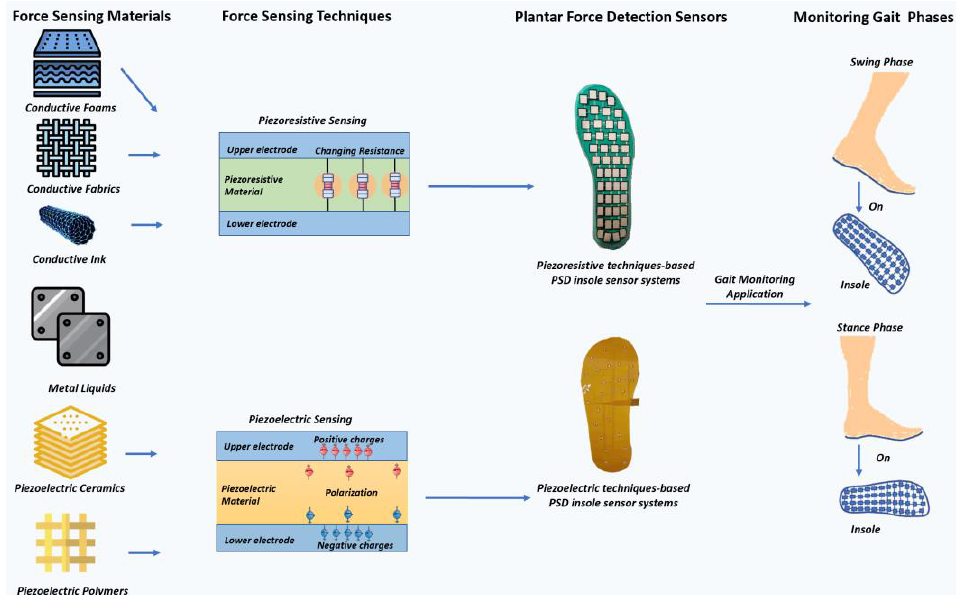
Figure 1. Mechanisms, representative types, and correspondent insole systems or PSD sensors composed of piezoelectric and piezoresistive materials. Piezoresistive system is produced in [11] and piezoelectric system is produced in [12].